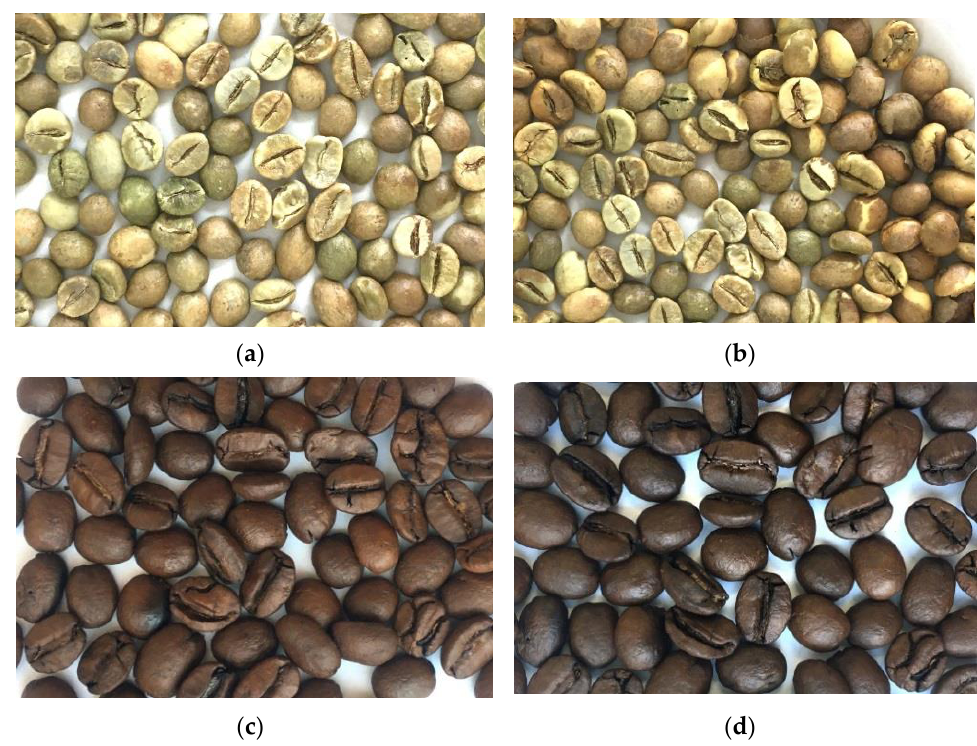
Figure A1. Images of green coffee beans before ( a ) and after ( b ) MWR treatment; medium roasted coffee beans ( c ) and dark roasted coffee beans ( d ).